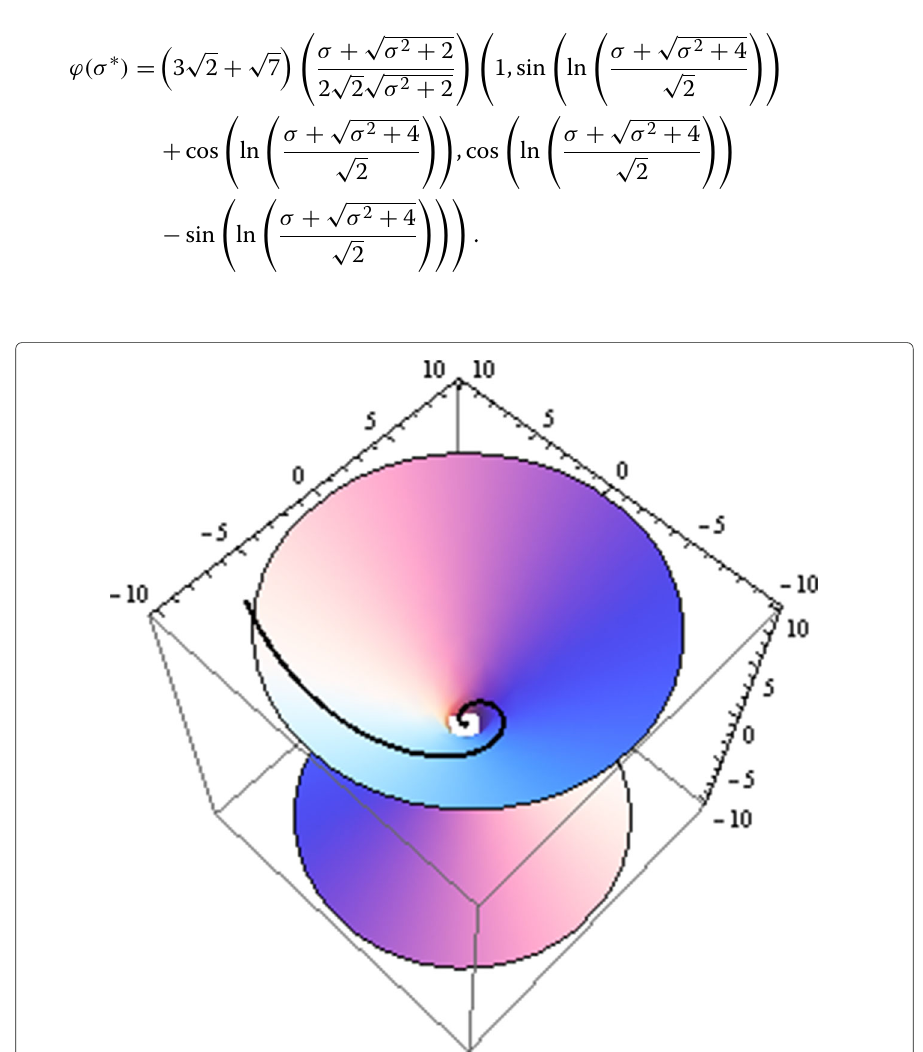
Fig. 4 The spacelike equiform-Bishop TB 2 -Smarandache curve ϕ(σ ∗ ) on S 2